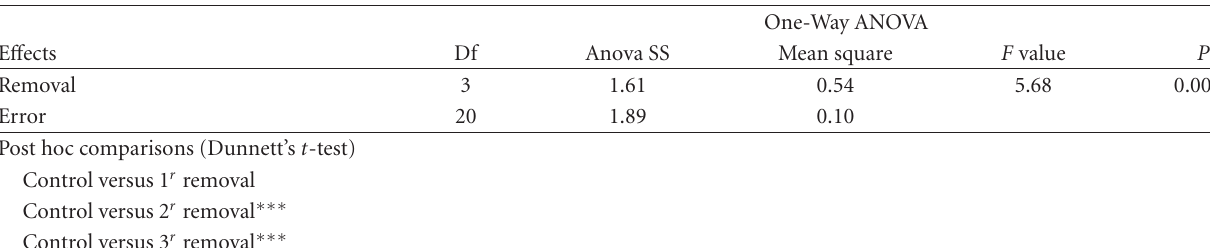
Table 6: One-Way ANOVA results for the removal of females regardless of their social rank (control: no manipulation; treatment 1: removal of 1 female, treatment 2: removal of 2 females, and, treatment 3: removal of 3